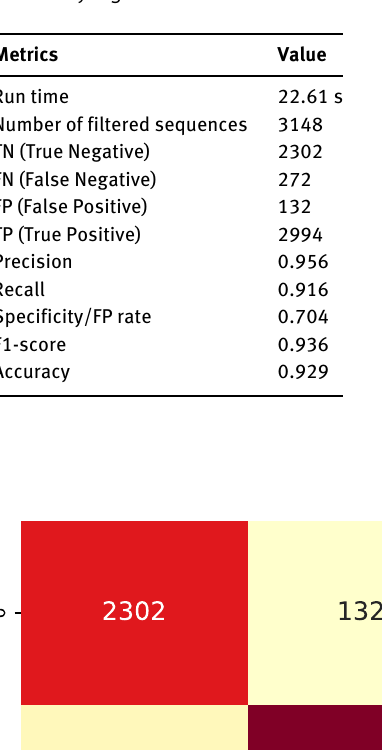
Table 7: Metrics obtained for the generalization test using LTR_STRUC data of Oryza granulata .